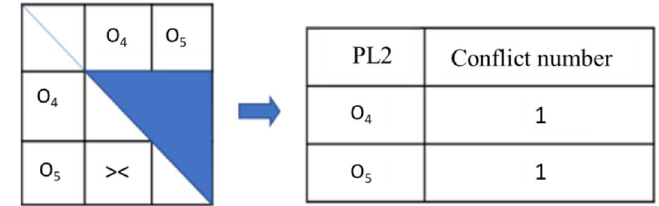
Table 8 The conflict number of OSs in class PL